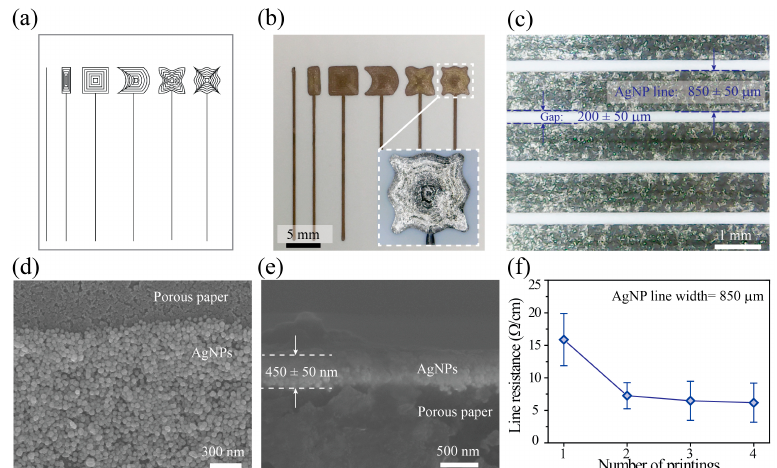
Figure 2. Printing silver nanoparticle (AgNP) electrodes on paper. ( a ) Electrode designs with various sizes and shapes, ( b ) electrodes printed with the designs in ( a ) and (inset) an enlargement of one design, and ( c ) printed AgNP lines. SEM images of the printed pattern: ( d ) top view and ( e ) cross-sectional view. ( f ) Surface electrical resistance of the printed AgNP line versus the number of printings.